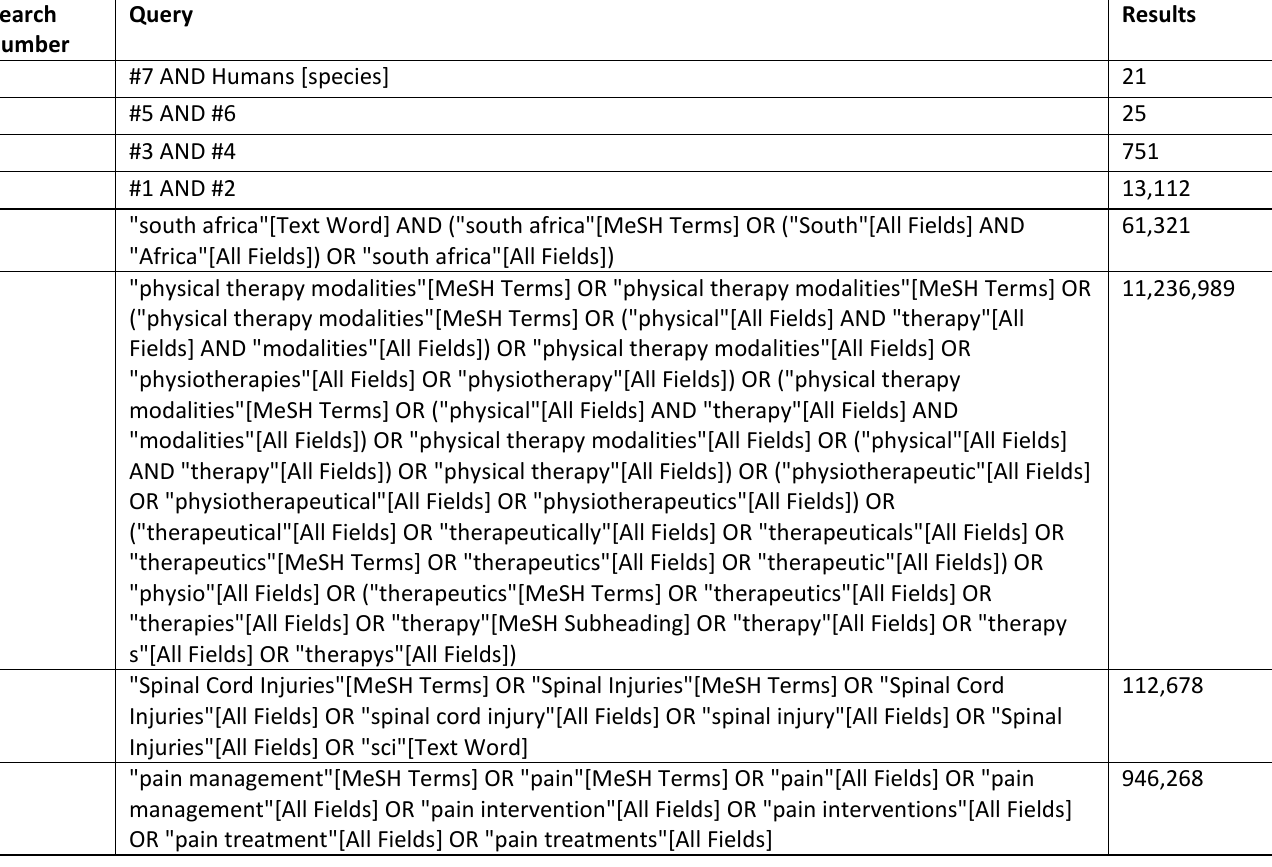
TABLE 1-A1 : Search strategy for MEDLINE (PubMed). Search conducted on May 20,